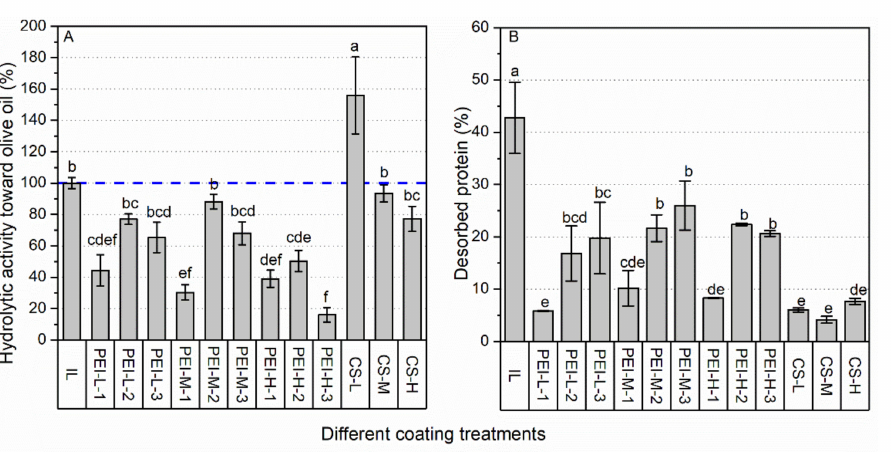
Figure 2. The effects of physical coating on hydrolytic activity ( A ) and stability against desorption ( B ). Different lowercase letters indicate significant differences among different coating treatments ( p <